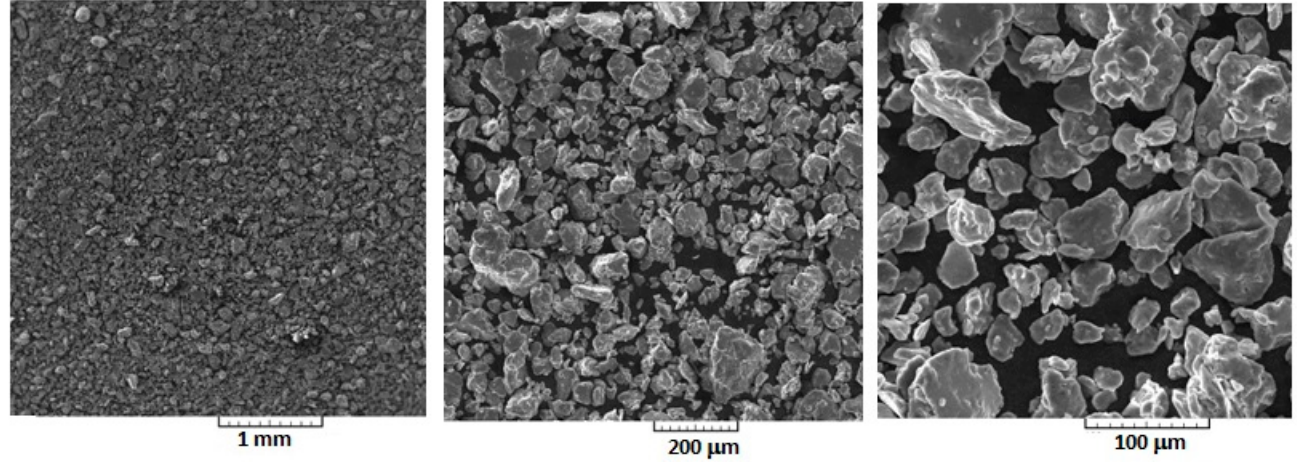
Figure 7. The Mg ‐ 10Zn ‐ 0.8Ca ‐ 0.5Zr (wt.%) alloy ‐ powder processed by mechanical alloying with [200 rpm/24 h/10:1] + [250 rpm/2 h/20:1].